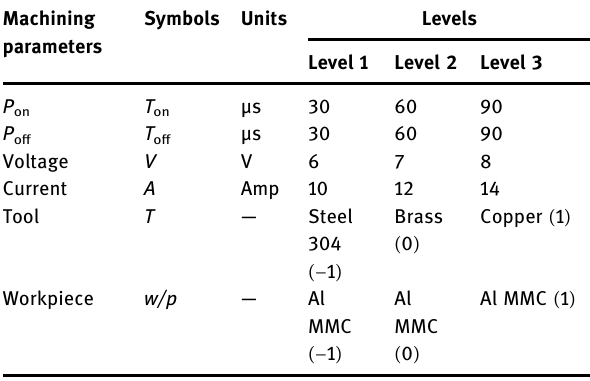
Table 2: Process parameters and their levels